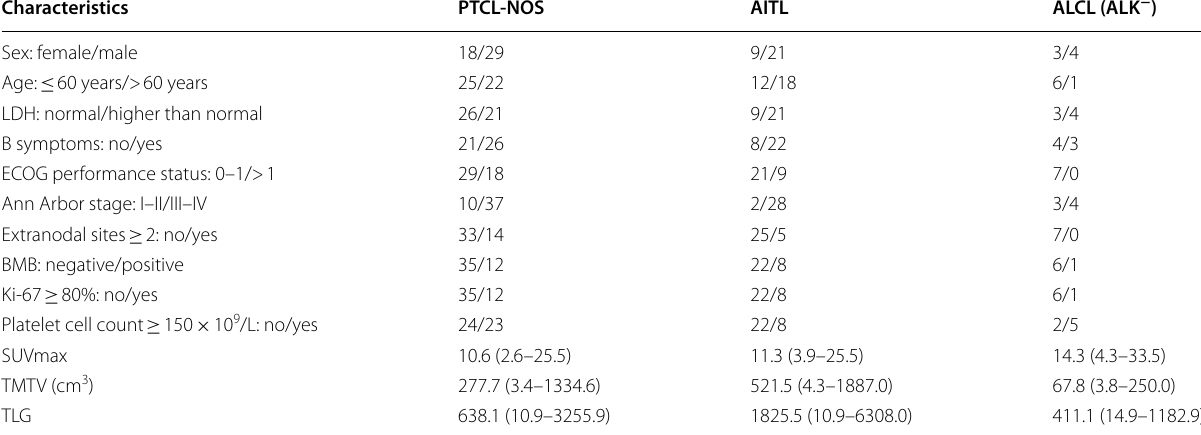
Table 2 Clinical and PET characteristics of different PTCL subtypes